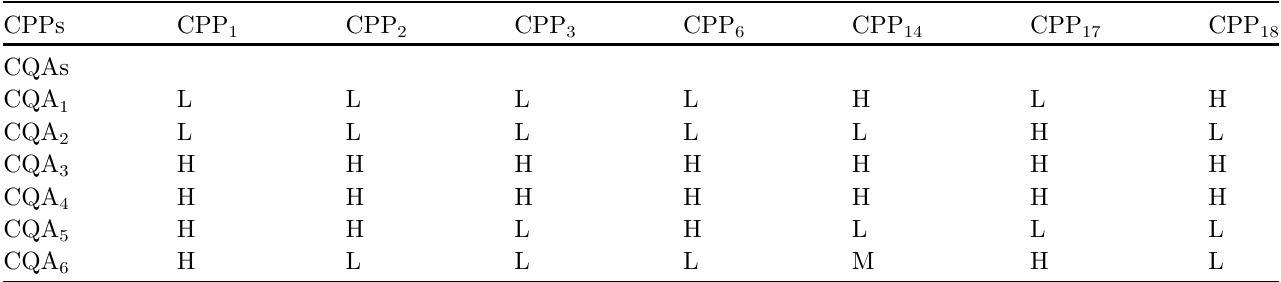
Table 4. Risk analysis to classify the degree of in fl uence between CQAs and CPPs as high (H), medium (M), or low (L)